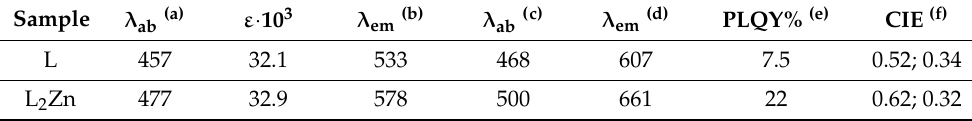
Table 1. Absorption and emission properties of L and L 2 Zn in solutions and in the solid state.